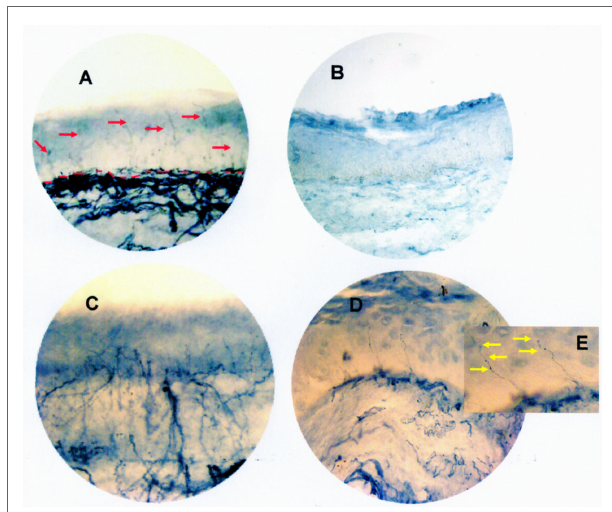
FigUre 2 | Mucosa biopsy section from the epiglottis site of a control subject (red arrows show nerve fibers; red dotted lines indicate the junction between epithelium and lamina propria) (a), of the first als patient (showing the lack of intraepithelial fibers in the entire thickness of the epithelium) (B), of the second als patient (showing an increased and chaotic nerve branching not crossing the whole epithelium) (c), and of the third als patient (showing large axonal swellings in many branches of the intraepithelial fibers) (D) . In the enlarged image (e) , yellow arrows point to the axonal swelling. All three ALS patients were dysphagic and had a laryngeal sensory deficit.